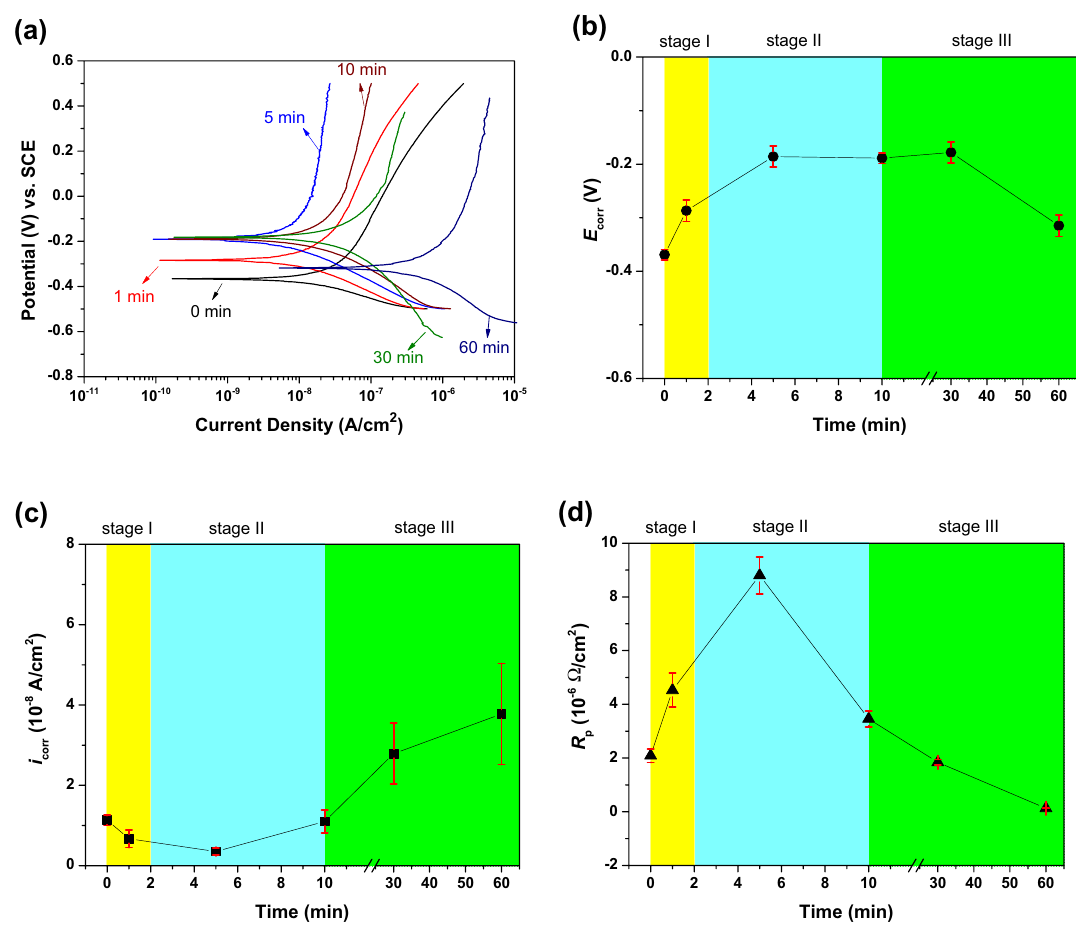
Figure 5. ( a ) Cathodic and anodic polarization Tafel curves for the TiZr alloy specimens heat-treated at 600 °C for various time intervals. The average ( b ) E corr , ( c ) i corr , and ( d ) R p values of the TiZr alloy as a function of heat treatment time. Sample (min) E corr